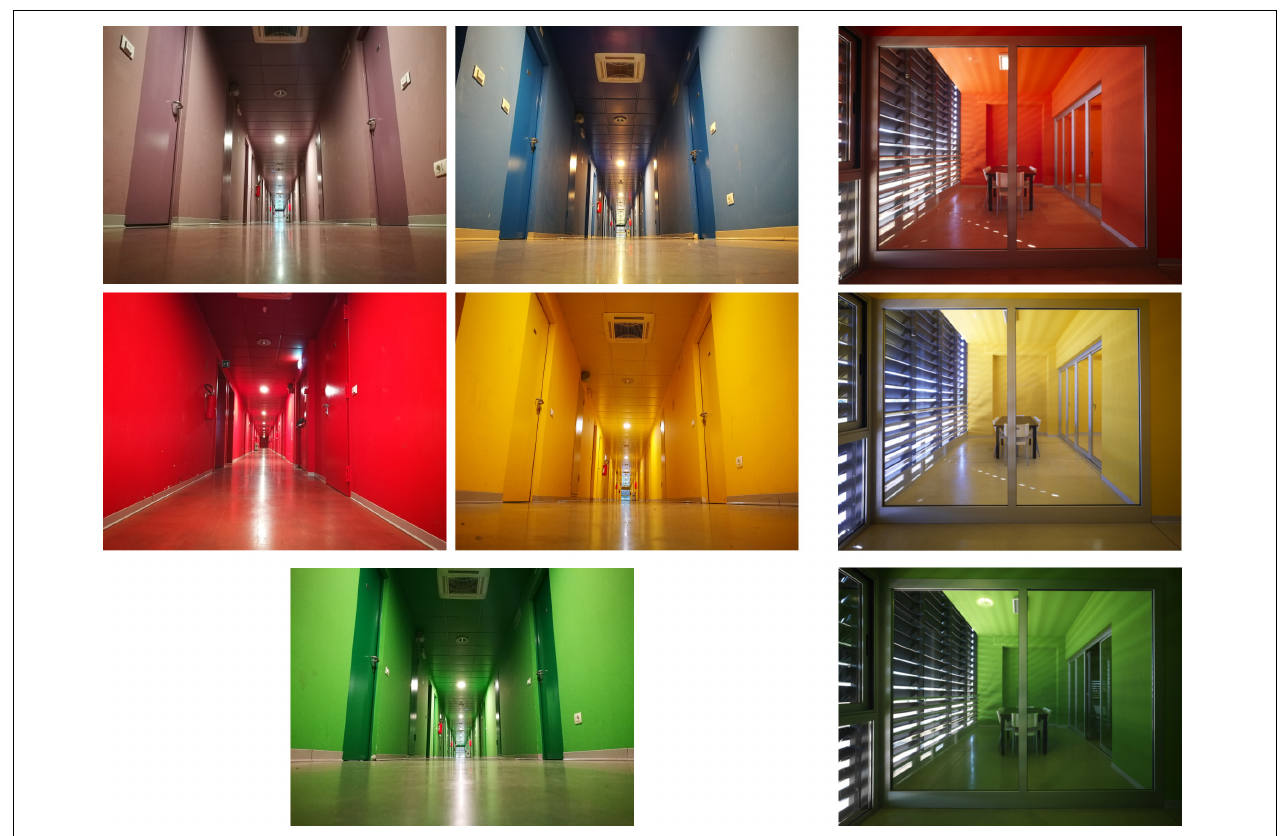
FIGURE 2 | Examples of five corridors (left) and three study rooms (right) of the university residence hall.